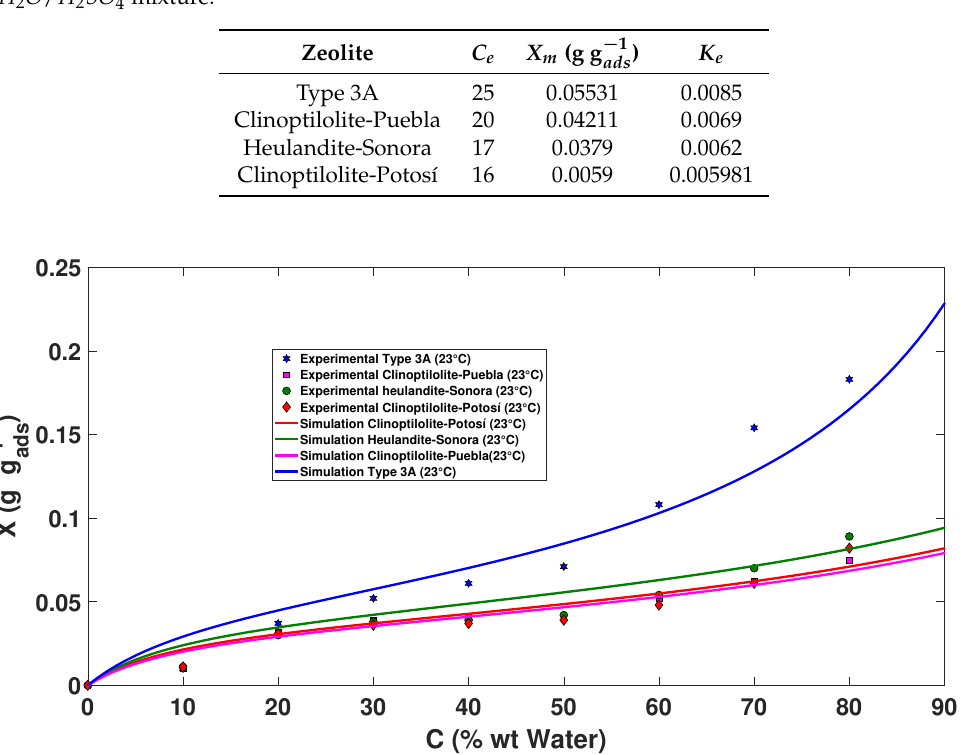
Figure 7. GAB adsorption isotherms for the H 2 O / H 2 SO 4